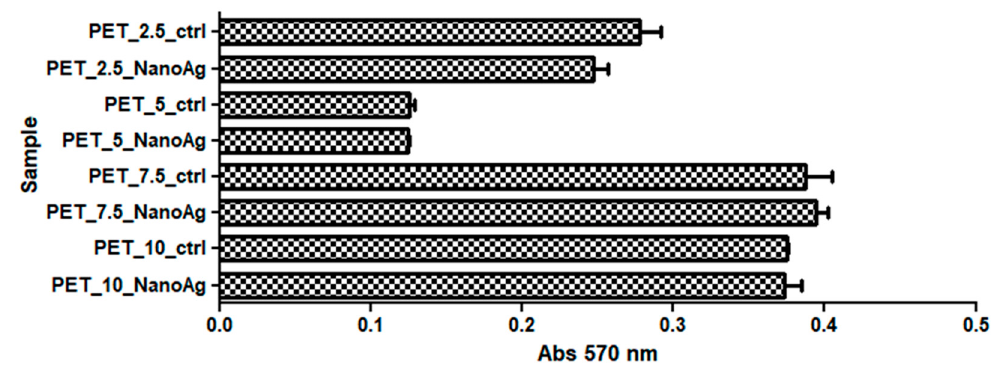
Figure 11. Effects of PET_X_NanoAg on MTT (3-(4,5-dimethylthiazolyl-2)-2,5-diphenyltetrazolium bromide) specific activities in amniotic fluid stem cells (AFSC).